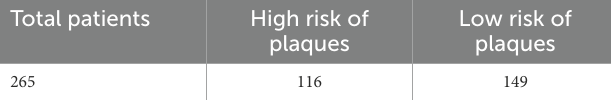
FIGURE 2 Sample Dataset, whereby (A,B) represents the original and marked image for carotid plaque, respectively.